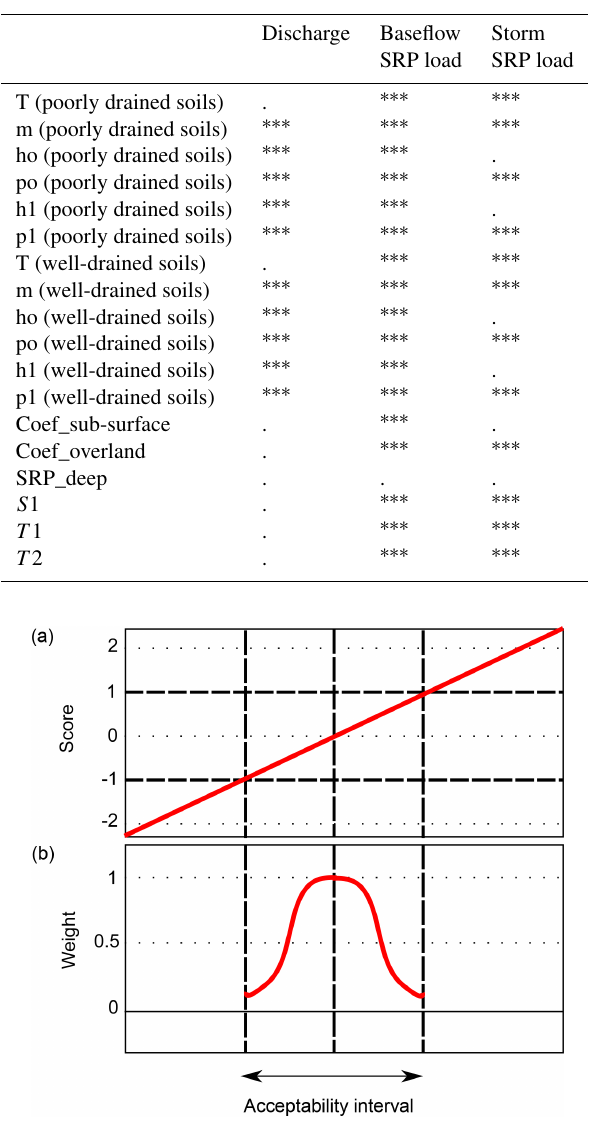
Table 2. Starting and ending dates of periods studied. Table 3. Sensitivity analysis of the model to 18 model parameters (insignificant “.”, important “ ∗ ”, critical “ ∗∗∗ ”). Parameters signifi- cations are detailed in Table 1.